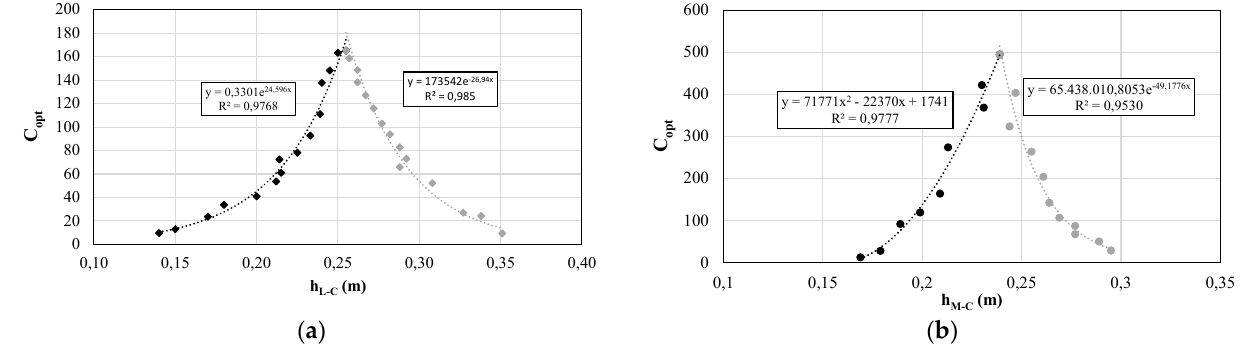
Figure 4. Trends of C opt as a function of the distance between optics and receiver in the case of Fresnel lens ( a ) and spherical mirror ( b ) in absence of secondary optics.